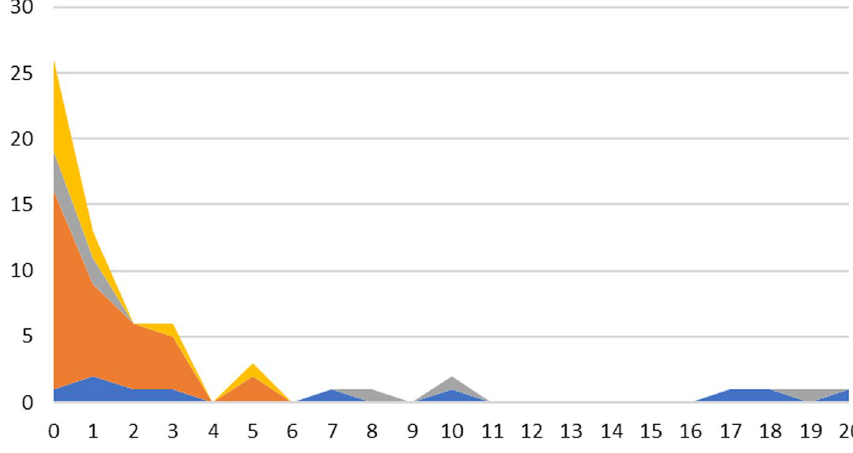
Fig. 3 Extraterritorial voting adoption-implementation gaps by regime type. Notes : Data from Wellman, Allen and Nyblade (Forthcoming). Implementation gaps are only reported for countries that both adopted and implemented extraterritorial voting between 1950 and